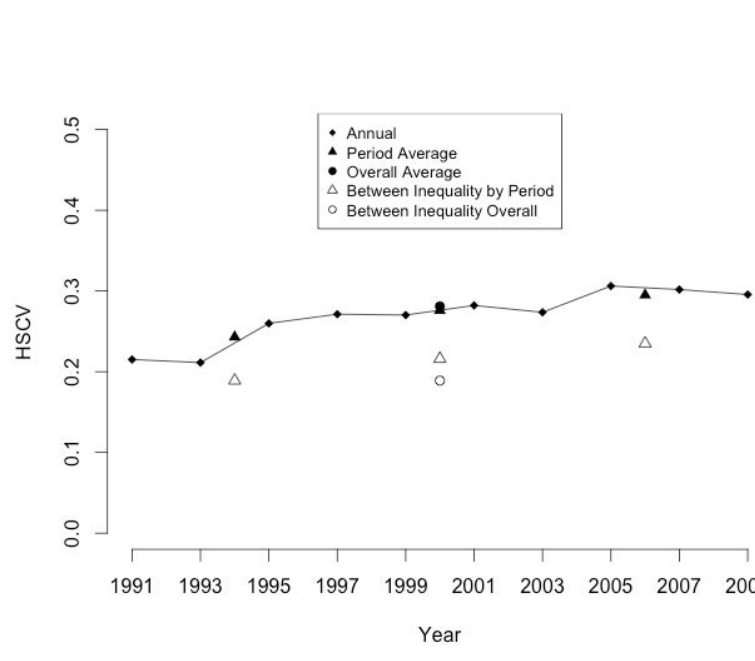
Figure 2: Inequality Measures, 1962–64 Cohort